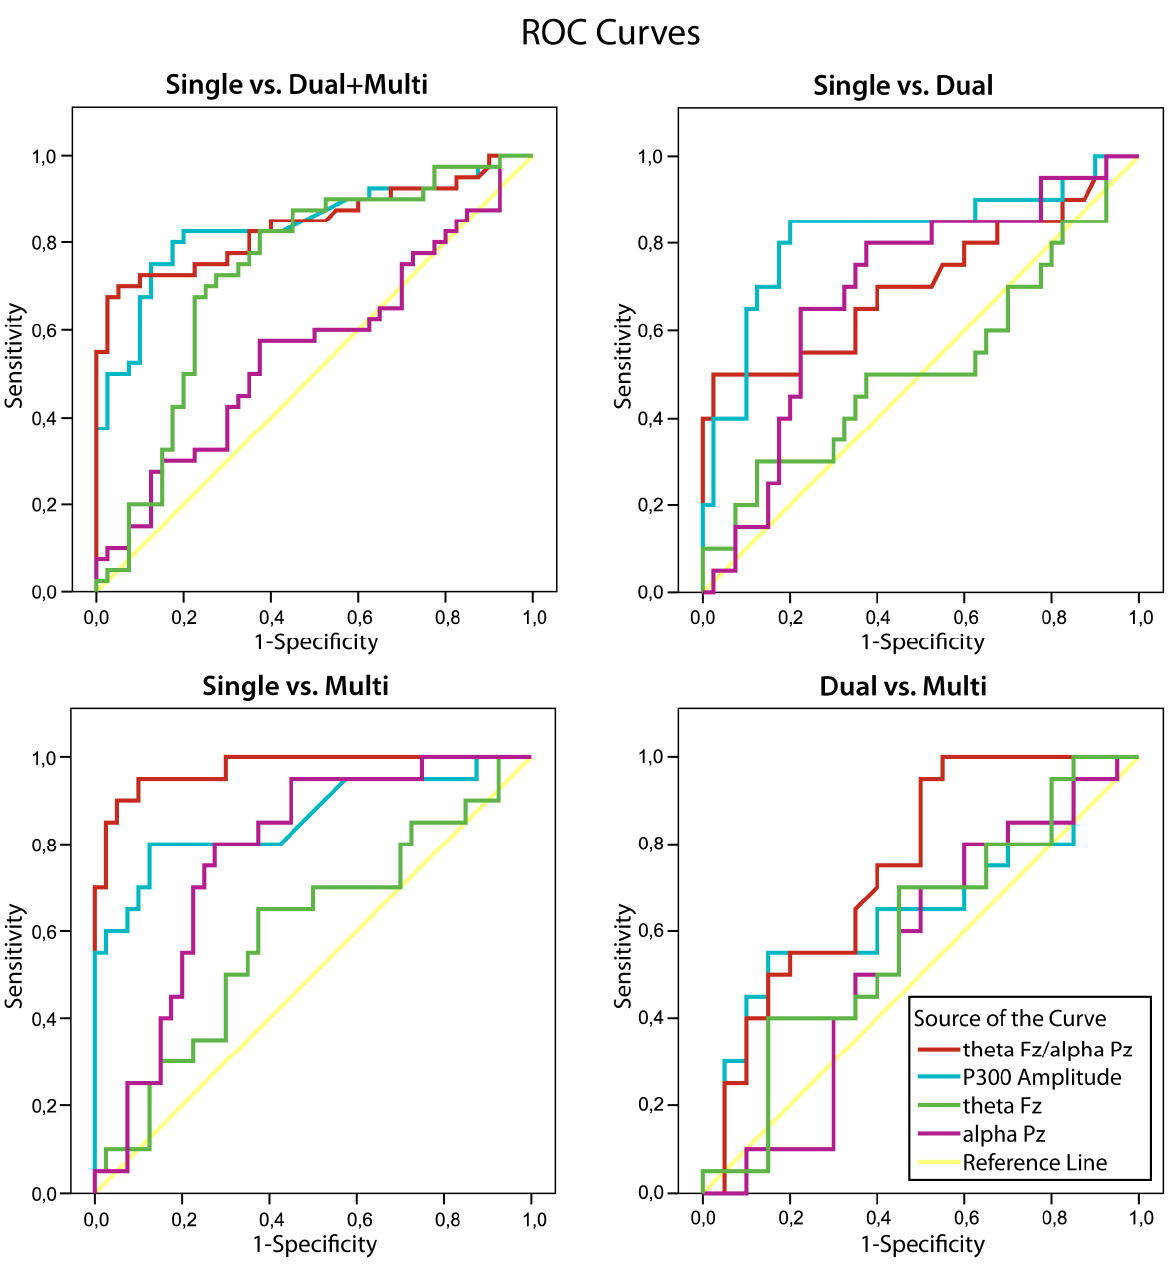
FIGURE 4. ROC curve comparisons of different brain metrics parameters . Area under a ROC curve is plotted for single vs. dual (upper left), single vs. multi (upper right), dual vs. multi (lower left), and single vs. dual + multi (lower right) situations. The P300 amplitude and theta Fz/alpha Pz ratio perform equally well in discriminating task demands. The alpha power also performs reasonably well, where as the theta power does